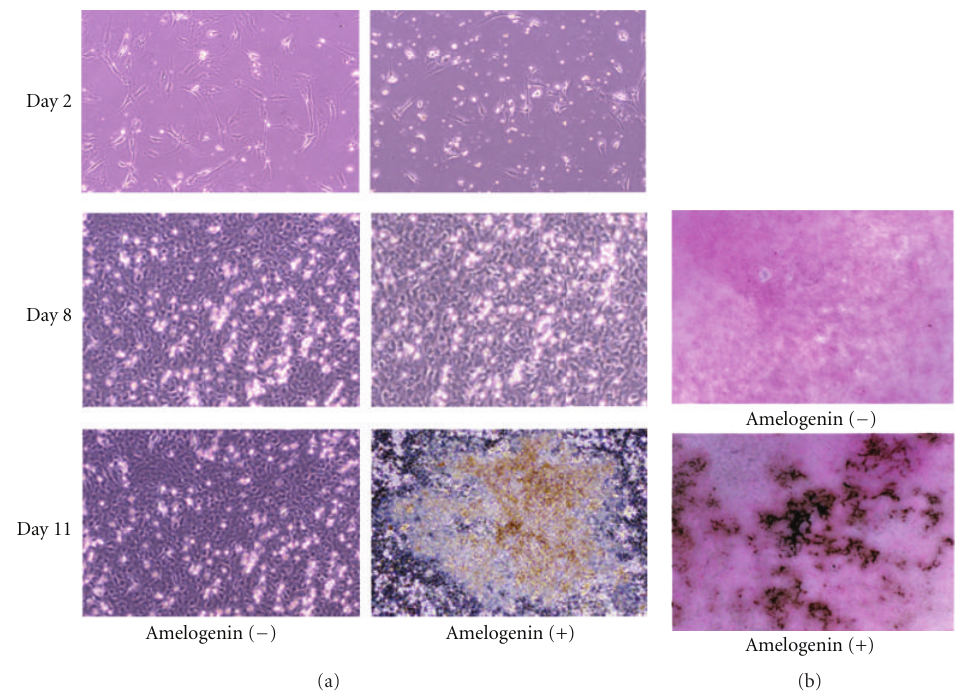
Figure 1: E ff ects of 100ng/mL of amelogenin on morphology and mineralization of rat bone marrow mesenchymal stem cells. (a) Phase- contrast features of rat bone marrow mesenchymal stem cells at 2, 8, and 11 days of culture with and without amelogenin (original magnification × 100). (b) Von Kossa staining of rat bone marrow mesenchymal stem cells at 11 days of culture with and without amelogenin (original magnification × 400).